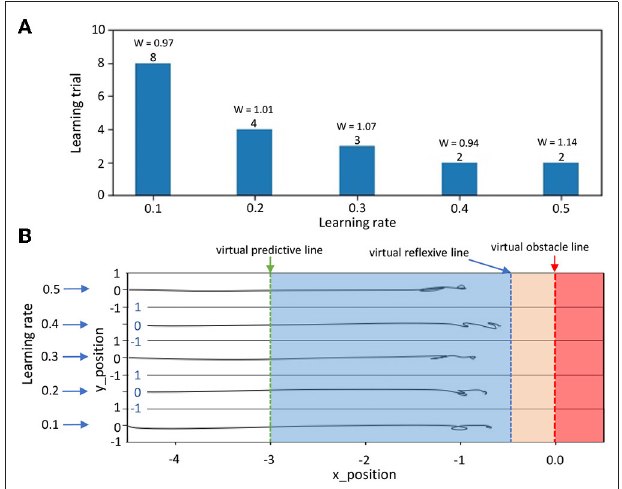
FIGURE A1 | (A) Learning trial required and the learned predictive weight for each learning rate. (B) Top view position tracking when the UAV flew using the learned predictive weights in (A) .